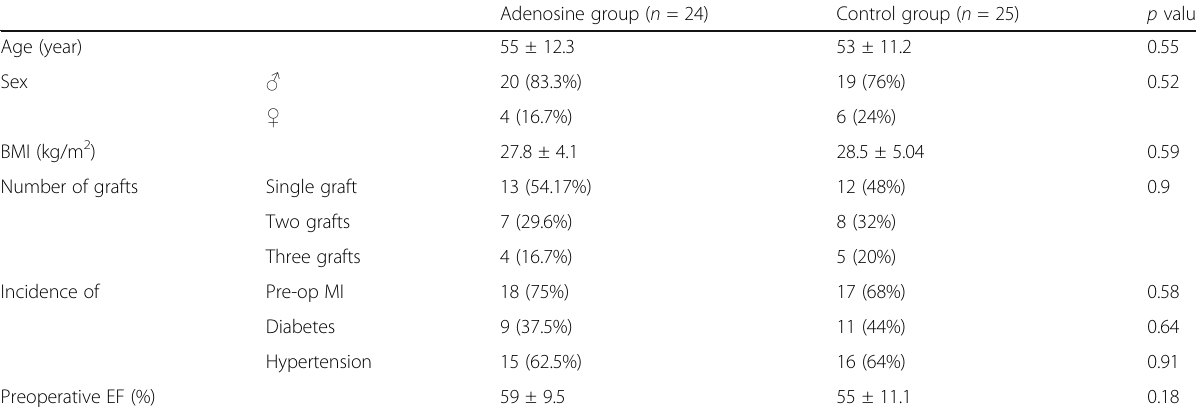
Table 1 Preoperative data and clinical characteristics